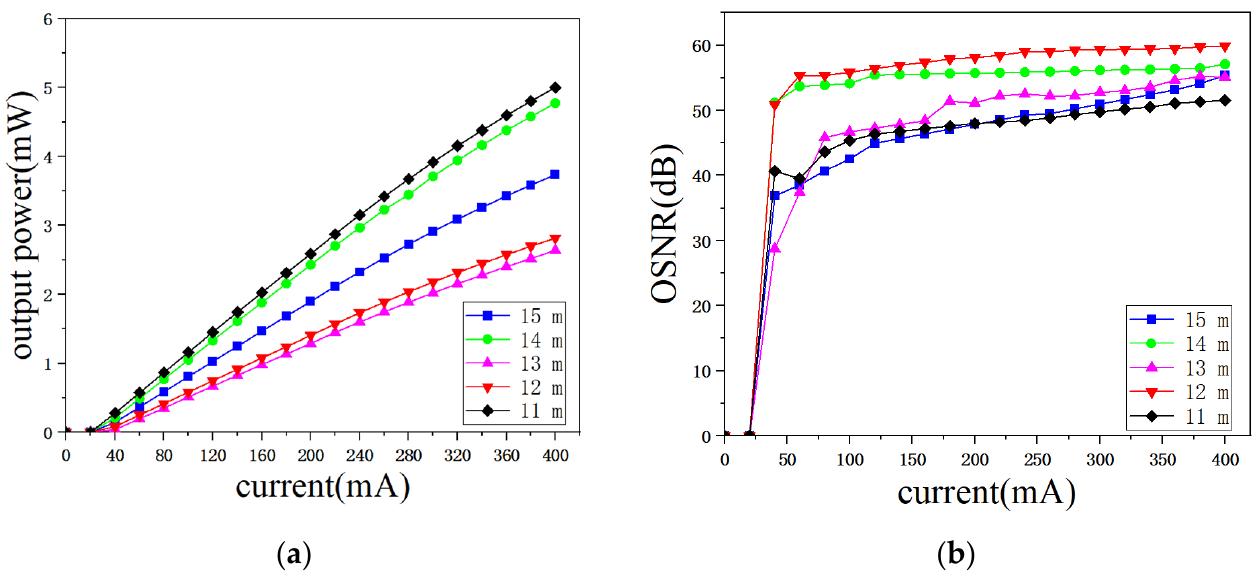
Figure 3. Effects of ( a ) output power against current, ( b ) OSNR against current in various EDF lengths. When the SMF lengths are 30-, 70-, 100-, 120-, 200-, and 280 m, respectively, the corresponding OSNR is as shown in Figure 4a. Since the reflectivity of the FBG is the